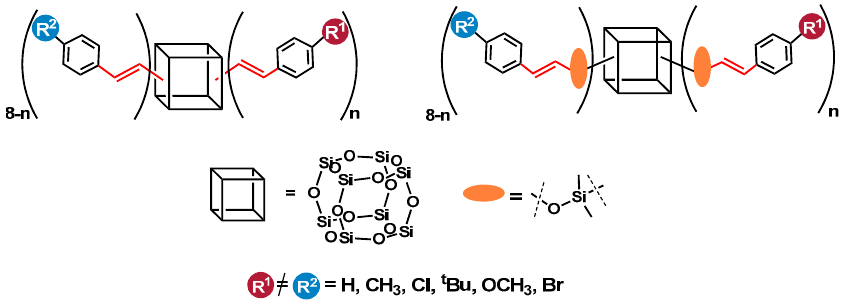
Figure 1. Silsesquioxanes with mixed functional groups obtained in this work.